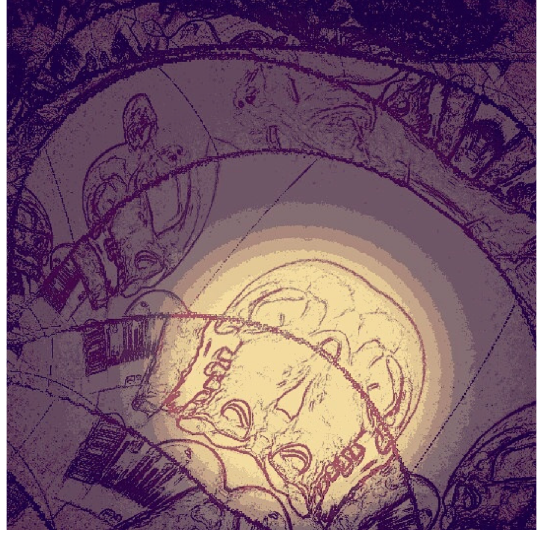
Figure 5 | “Big Brain Mask”.